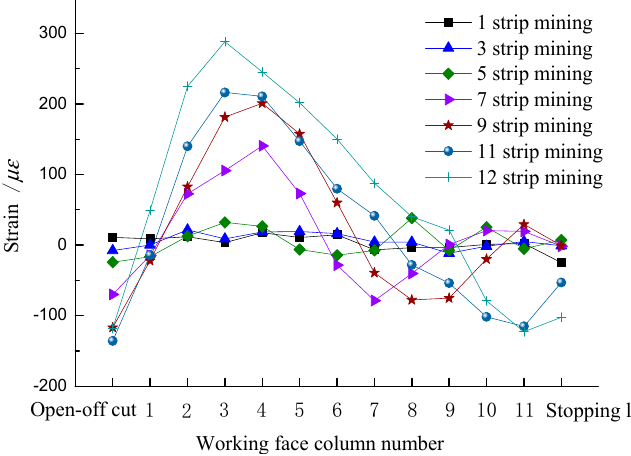
Figure 5. Strain change and distribution map of each pillar in layer II along with excavation of the coal face.